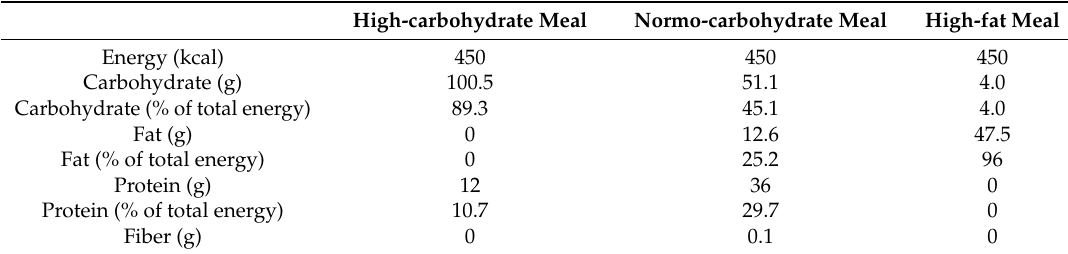
Table 2. The energy and macronutrients composition of meals. High-carbohydrate